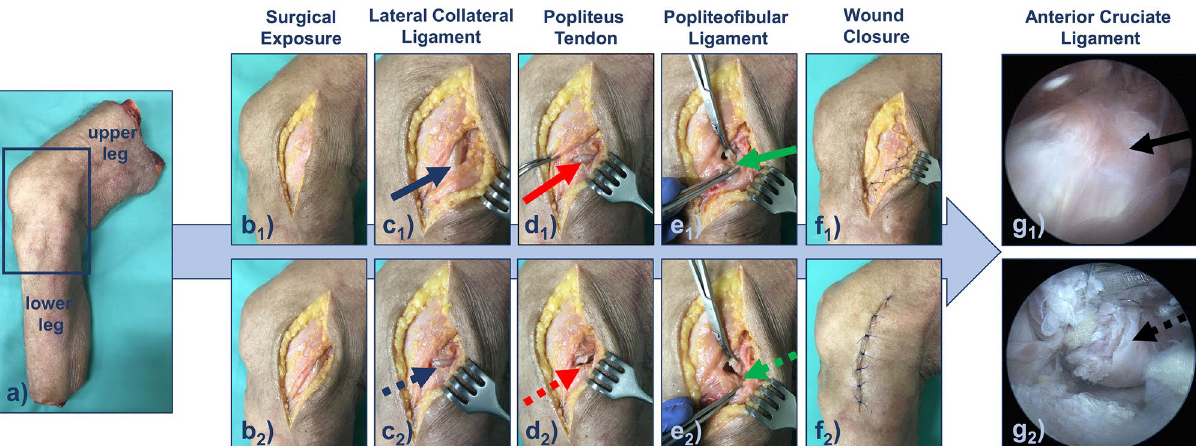
Figure 4. Graded injury model of the posterolateral corner and the anterior cruciate ligament. The joint ( a ) was subjected to standardized sequential surgical transections. After exposure ( b 1 ) and splitting of the fascia ( b 2 ), the lateral collateral ligament (blue arrow, c 1 ), the popliteal tendon (red arrow, d 1 ), and the popliteofibular ligament (green arrow, e 1 ) were exposed. Sequentially, these structures were surgically transected to emulate complete LCL injury (dotted blue arrow, c 2 ), additional complete PT injury (dotted red arrow, d 2 ), and additional complete PFL injury (green dotted arrow, e 2 ). Each transection was followed by layer-wise adaptation and suturing of the fascia ( f 1 ) and skin ( f 2 ). Arthroscopically, the anterior cruciate ligament was identified (black arrow, g 1 ) and completely transected at mid-substance (dotted black arrow, g 2